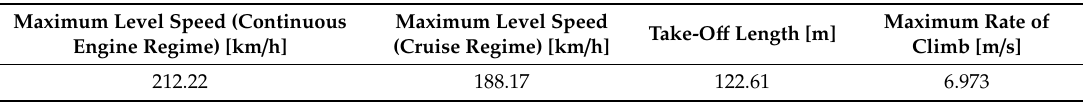
Table 7. Aircraft performance with chosen optimal propeller (diameter D = 2.05 m and pitch blade angle φ 0.75 = 20 ◦